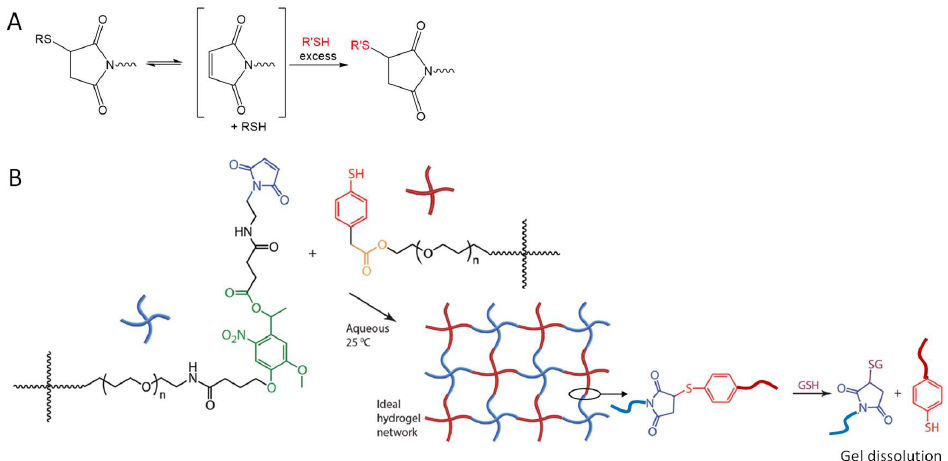
Figure 15. Retro Michael-type addition ( A ) can be utilized to break down networks of crosslinked polymers on demand ( B ) in the presence of soluble thiols (e.g., glutathione, GSH), as an orthogonal method to the degradation by light (the reactive group shown in green) and hydrolysis (the reactive group shown in orange). Image B modified with permission from [71]. Copyright 2015 RSC.